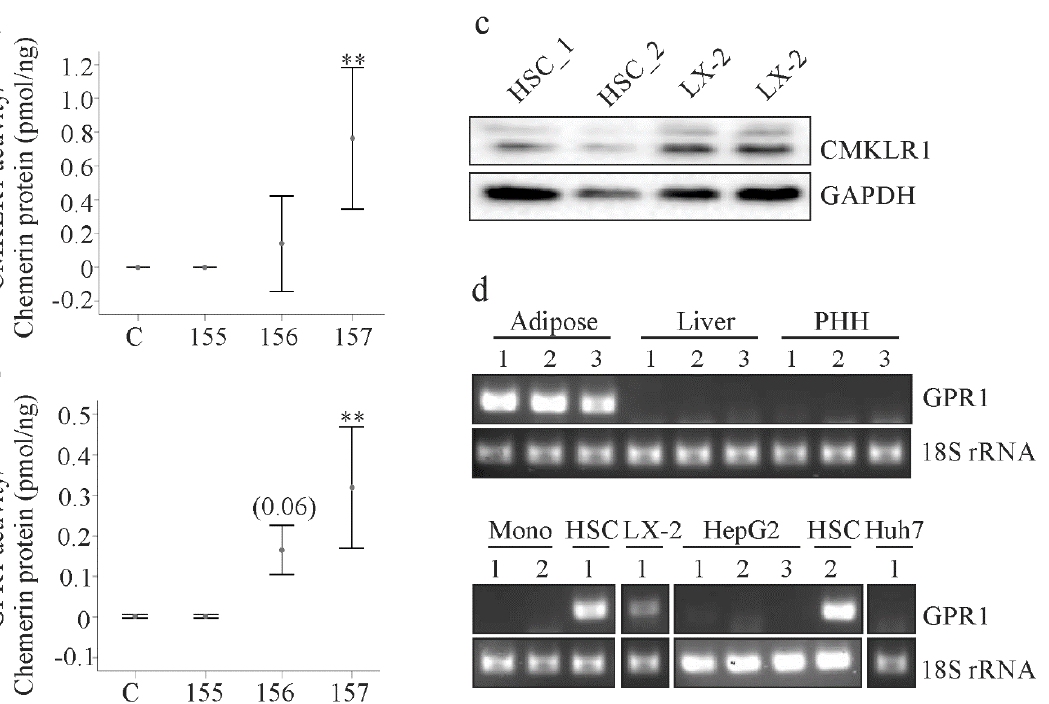
Figure 2. Chemerin activity and expression of chemerin receptors. ( a ) Activation of CMKLR1 by chemerin isoforms in the supernatants of the transfected LX-2 cells. Activity relative to chemerin concentration is shown ( n = 4); ( b ) Activation of GPR1 by chemerin isoforms in the supernatants of the transfected LX-2 cells. Activity relative to chemerin concentration is shown. Number in brackets is the p -value ( n = 4); ( c ) CMKLR1 protein in LX-2 cells and primary human hepatic stellate cells (HSC_1, HSC_2 of 2 donors); ( d ) GPR1 mRNA in human adipose tissues of three donors, in liver tissues of three donors, in primary human hepatocytes (PHH) of three donors, in primary human monocytes (Mono) of two donors, in HSC of two donors and in the cell lines LX-2, HepG2 and Huh7. ** p < 0.01.